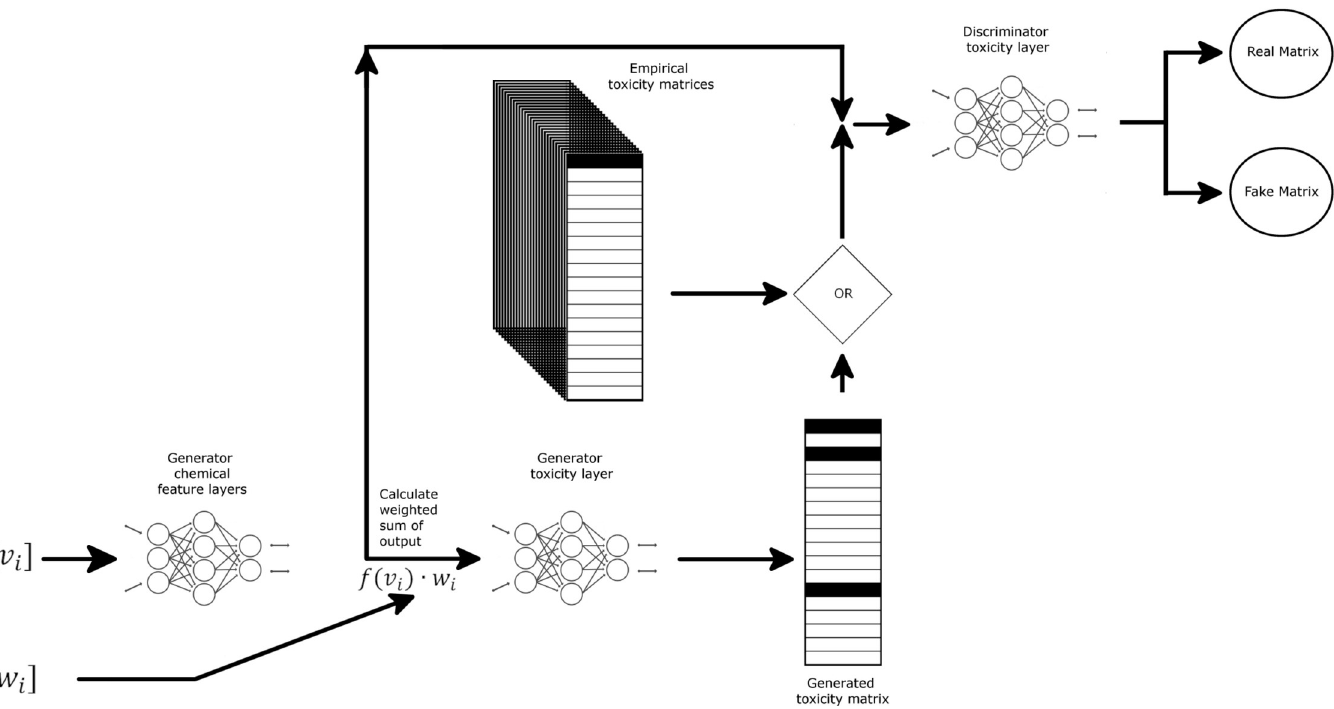
Fig 2. Conditional GAN diagram. Schematic representation of GAN-ZT architecture showing chemical structural input represented as weights (w i ) and views (v i ) matrices passed through two fully connected neural networks to produce a predicted toxicity matrix. Chemical features along with predicted or empirical toxicity matrices are then passed to a discriminator comprising a fully-connected neural network. Darker matrix shading indicates higher toxicity values.